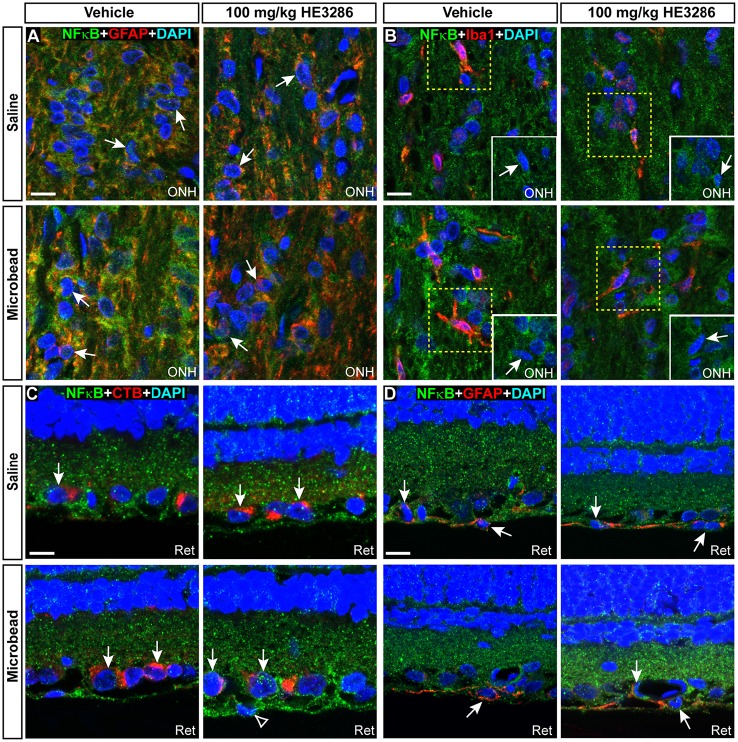
NFκB localizes to glial nuclei in optic nerve head and to glial and neuronal nuclei in retina. Representative confocal images of NFκB (green) localization in DAPI-stained nuclei of astrocytes (A, GFAP) and microglia (B, Iba1) in optic nerve head (ONH) of vehicle- and HE3286-treated rats. Inset in (B) is region contained within dashed box with red channel removed to better visualize nuclear localization of NFκB. In retina (C,D), NFκB localizes to nuclei of RGCs with CTB uptake and GFAP-labeled astrocytes within the retina (Ret). Arrows indicate cells positively-identified by specific label. Scale: 10 μm.